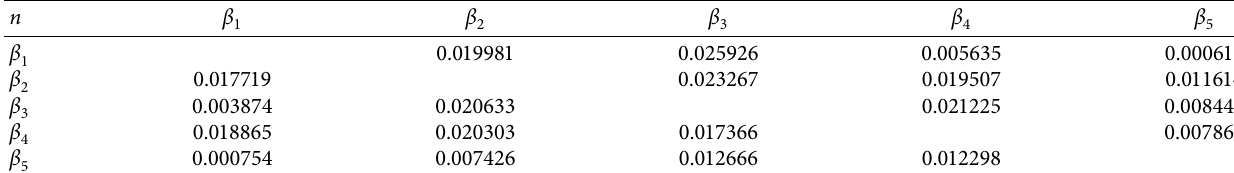
Table 20: Results of distribution grade intersection belief to each grade.